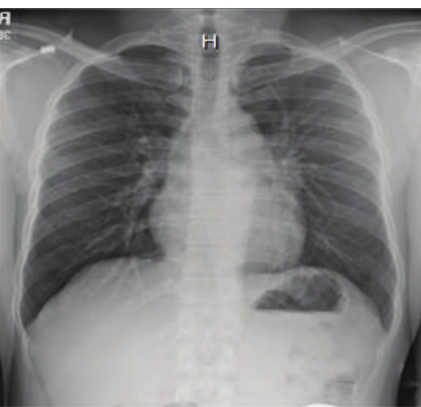
Figure 1: Chest X-ray (PA view) with left hilar fullness but no pulmonary lesions.